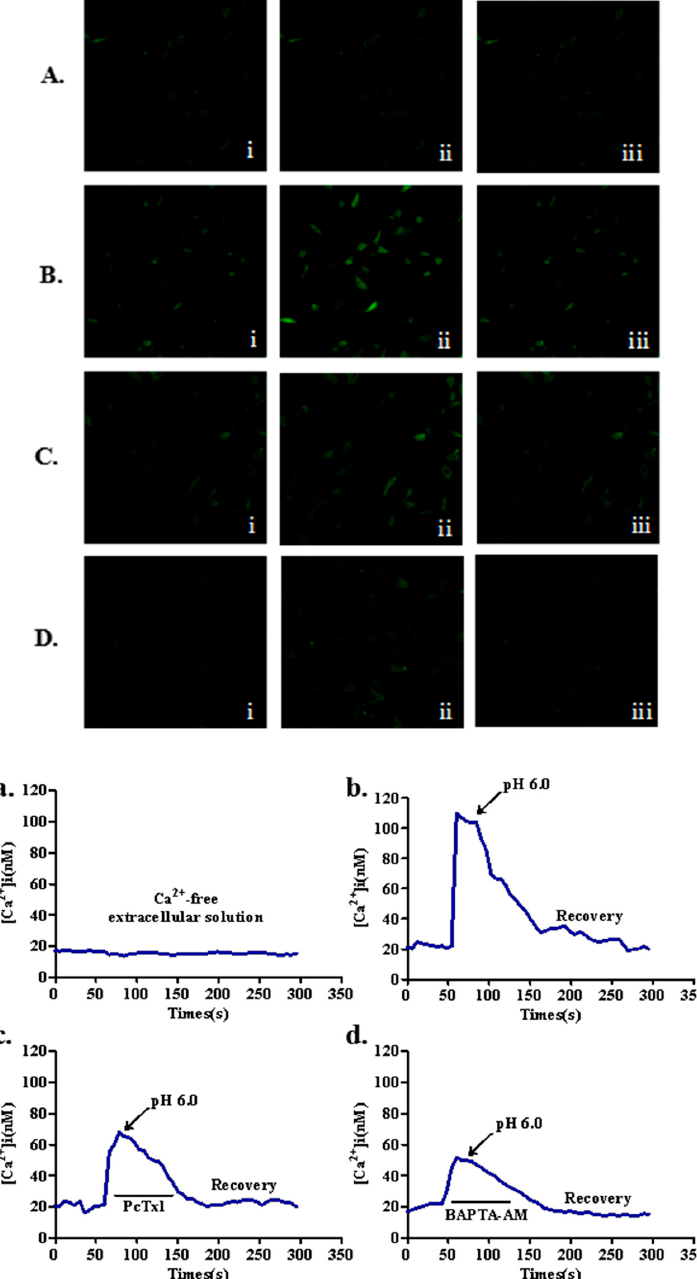
Figure 3. Blockade of ASIC1a with PcTx1 reduces acid-induced elevation of (Ca 2+ ) i level in articular chondrocytes. Cellular confocal micrographs of the same scale showing the changes in the (Ca 2+ ) i concentration, as visualized by Fluo-3-AM in articular chondrocytes. ( A , a ) acid-induced increase of (Ca 2+ ) i in Ca 2+ -free extracellular solution; ( B , b ) acid-induced increase of (Ca 2+ ) i in extracellular Ca 2+ solution; ( C , c ) acid-induced increase of (Ca 2+ ) i in articular chondrocytes pretreated with ASIC1a-specific blocker, PcTx1; ( D , d ) acid-induced increase of (Ca 2+ ) i in articular chondrocytes pretreated with calcium chelating agent, BAPTA-AM. The amplitude of (Ca 2+ ) i intensity in articular chondrocytes induced by acid treatment was quantified as the maximal rise of (Ca 2+ ) i above basal levels. ( i ) before exposure to acid solution; ( ii ) increased Ca 2+ intensity when pH was decreased to 6.0; ( iii ) after exposure to the acid solution for three minutes ( n = 8 for each).